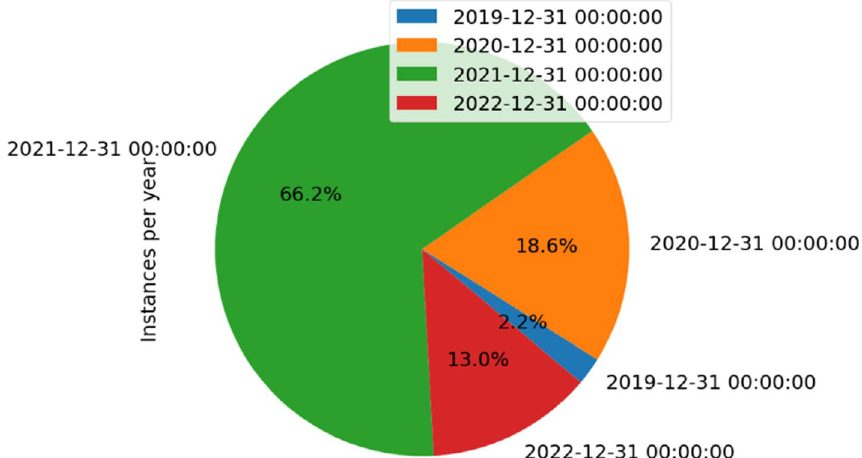
Fig. 12 Yearly distribution of electricity load profiles in cluster 5 (231 samples from the 2015–2022